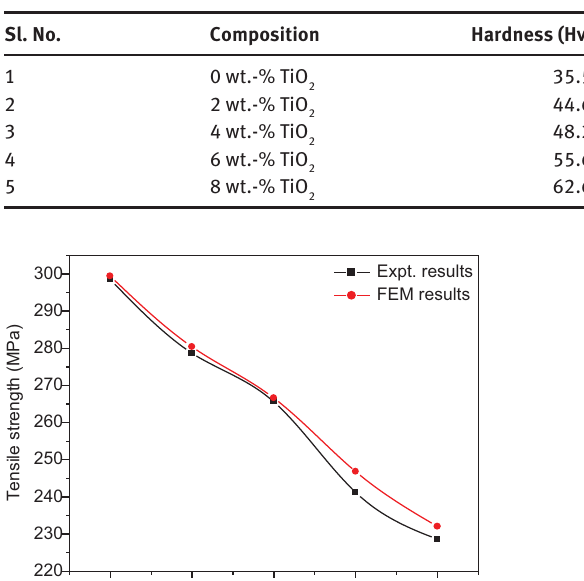
content on tensile strength of alloy 2